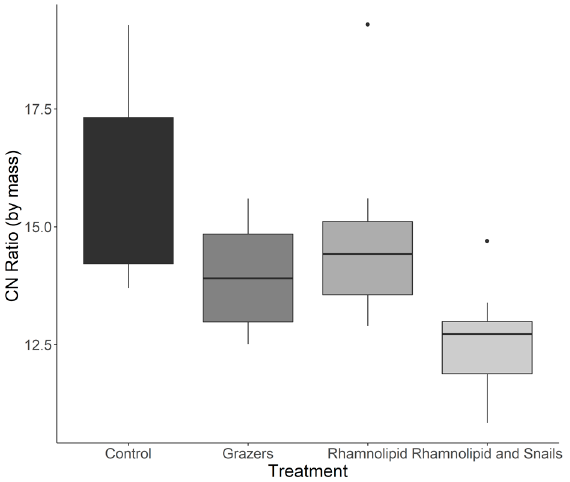
Figure 2. Carbon: nitrogen ratios of marine microbial biofilms ( n = 8) exposed to predation by either the common periwinkle snail and/or 150 ppm rhamnolipid for 14 days. Dots indicate outliers in the data for figure visualization.